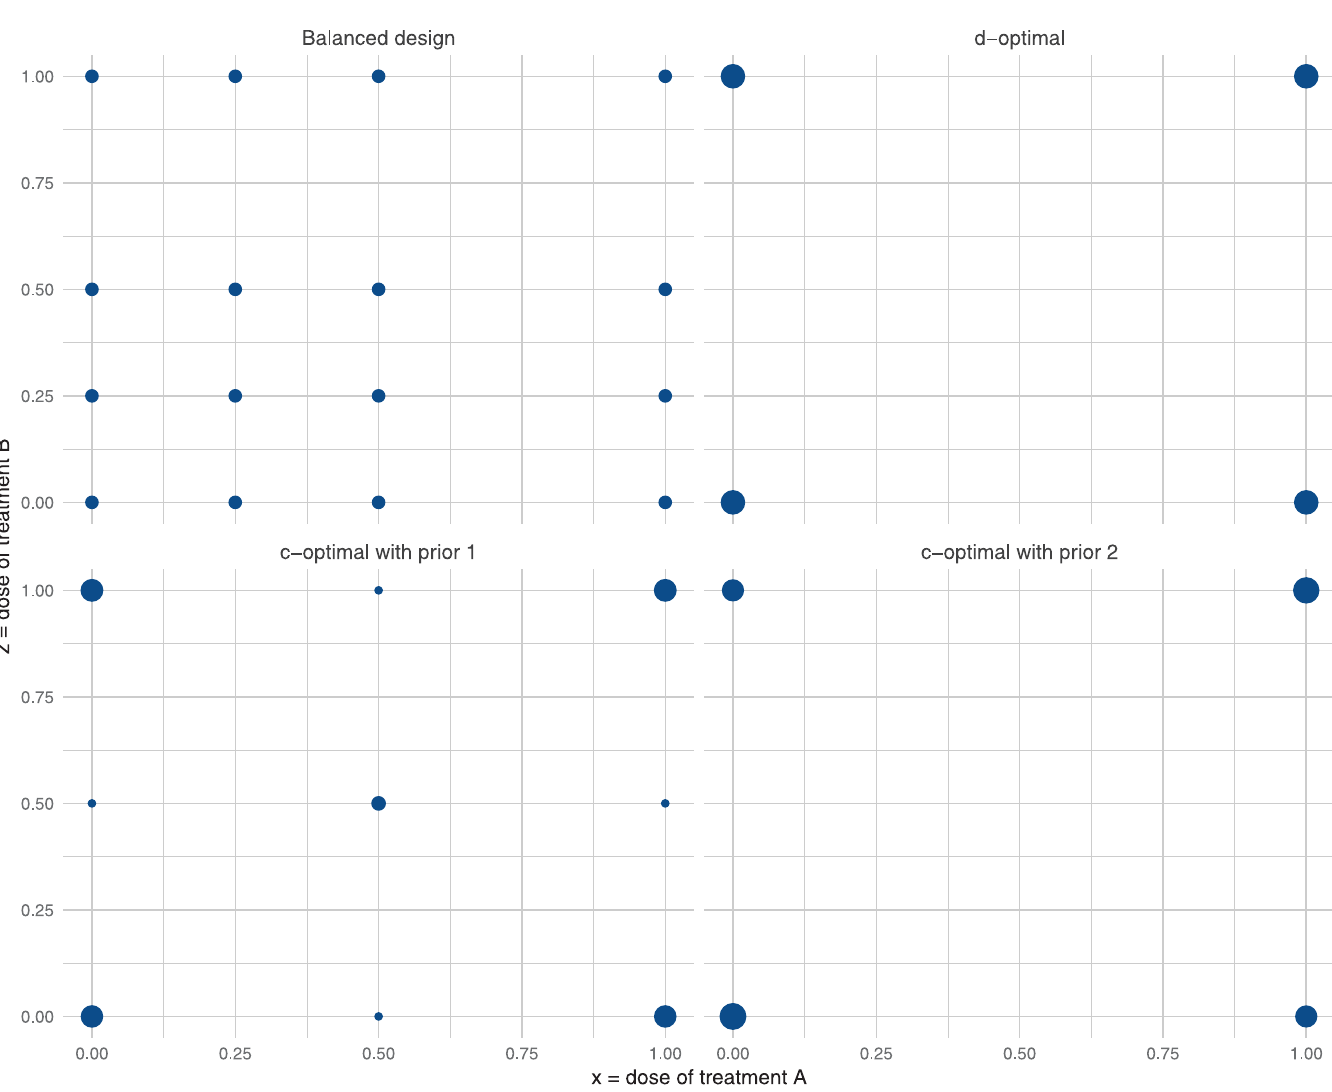
Fig 7. Experimental designs. Unlike the balanced design (the same proportion of experimental units across all concentration points), the d-optimal design and the c- optimal design with prior 2 distribute experimental units at the extreme points (0, 0), (0, 1), (1, 0), and (1, 1). The c-optimal design with prior 1 (non-informative prior) seeks information at a variety of concentration